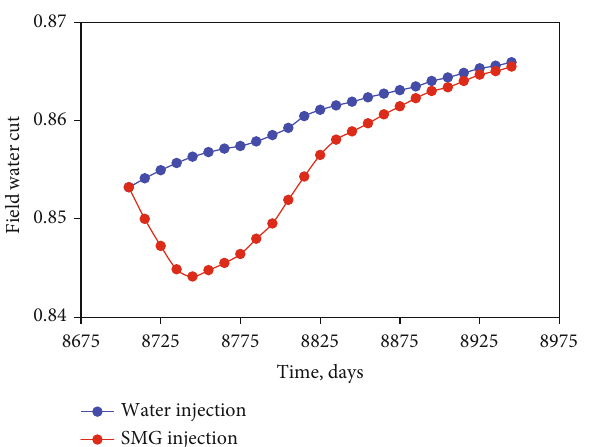
Figure 18: Change in water cut after microgel